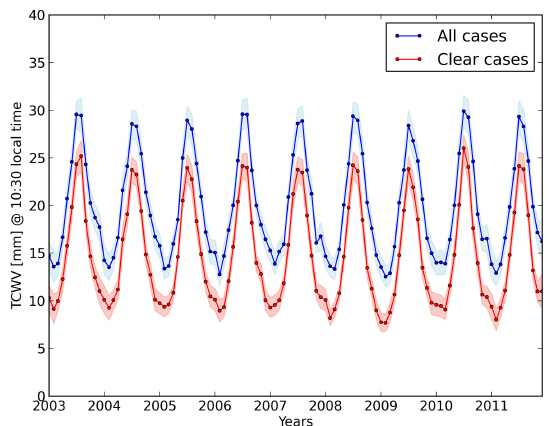
Figure 11. Monthly mean TCWV of all selected stations for cloudy scenes in blue and non-cloudy scenes in red lines.The shading indi- cates the 95% significance